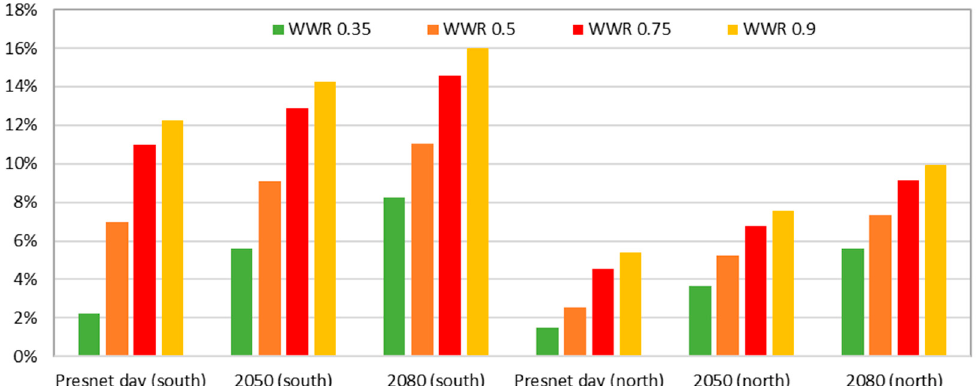
Figure 7. Annual percentage beyond the acceptable temperature 25 °C (tight building model) based on the Passive House Planning Package (PHPP).